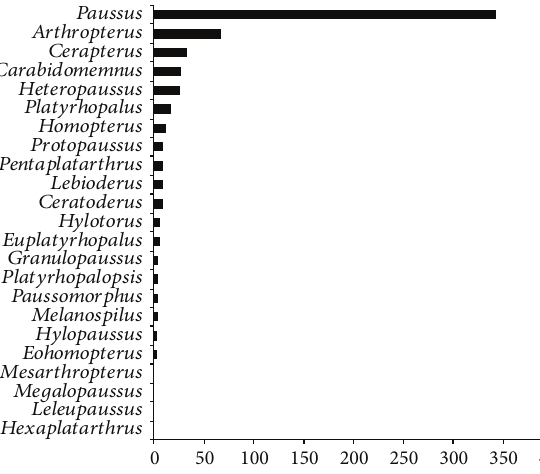
Figure 10: Number of species per genus in the tribe